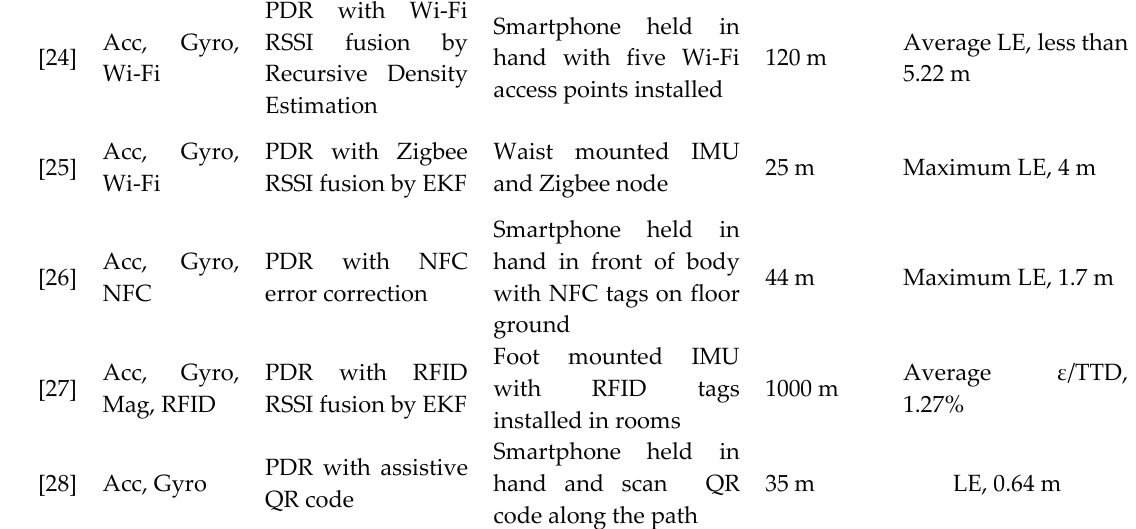
* Acc = Accelerometer, Gyro = Gyroscope, Mag = Magnetometer, BN = Beacon Node, QR = Quick Response; ** TTD = total travelled distance, ε /TTD = final position error over total travelled distance, SD = step detection, LE = Localization Error, HE = heading